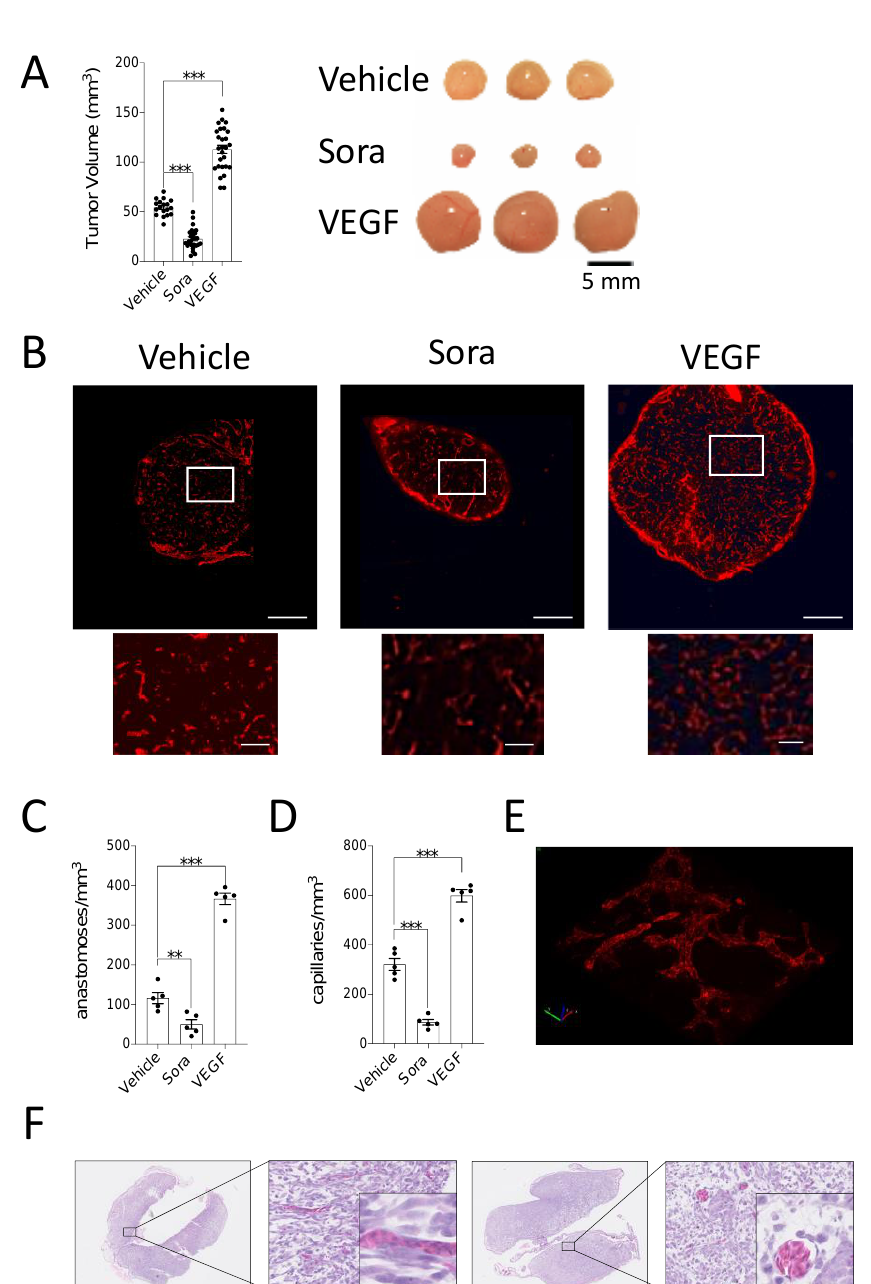
Figure 2. ( A – D ) HT-1080 cell suspensions were inoculated onto the CAM in the presence or absence of VEGF while Sorafenib (Sora) or DMSO (Vehicle) were added topically to the developing tumors every day. ( A ) Tumor volumes were calculated after 7 days of growth and representative images of tumors are shown ( n = 18–27). ( B – D ) LCA was injected into CAM vasculature prior to tumor extraction. ( B ) Representative immunofluorescence images and corresponding zooms showing vascularization in the control and treated tumor xenografts (LCA; red). Scale bar = 500 μ m. Zoomed area is out- lined in white, scale bar =100 μ m. ( C , D ) Quantification of the number of anastomoses ( C ), and capillaries ( D ) per mm 3 are shown ( n = 5). ( E , F ) 3D reconstruction of the CAM vasculature using Imaris Software ( E (Video S1)) and representative H&E staining of HT1080 tumor xenografts cultivated on the CAM for 7 days ( F ). Higher magnification shows the presence of chicken nucleated erythrocytes. S cale bars, 100 μm. Inset scale bars, 25 μm. Bars represent the mean ± SEM. The asterisks (*) correspond to p < 0.01 (**), and p < 0.001 (***), one-way Anova.